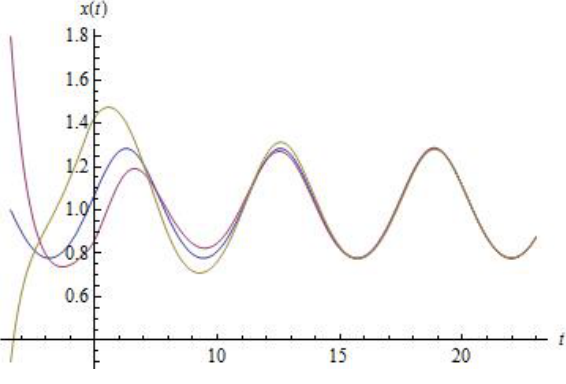
Fig. 1. Numerical simulation of exponential